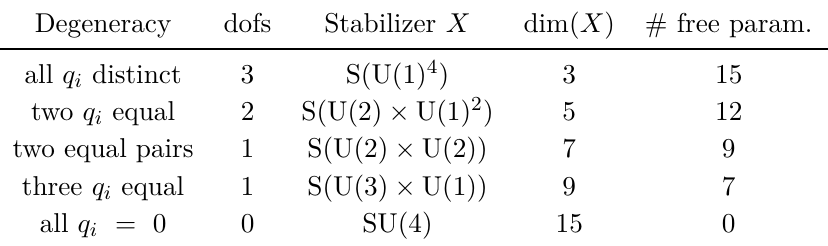
Table 2 . Stabilizer subgroups X of SU(4) acting on L ∈ su (4) , depending on the degeneracy of the eigenvalues q i . The last column indicates the number of free parameters for the coupling flow operator. It is computed by adding the number of degrees of freedom (dofs) in the choice of the q i ’s to the dimension of the orbit SU(4) /X